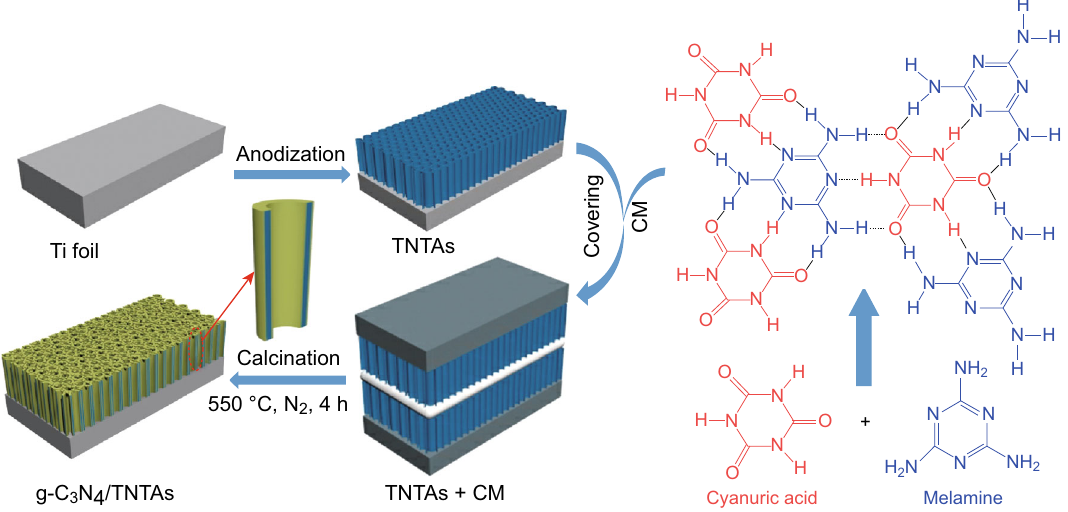
Fig. 1 Schematic diagram of the preparation of TNTAs and g-C 3 N 4 /TNTA